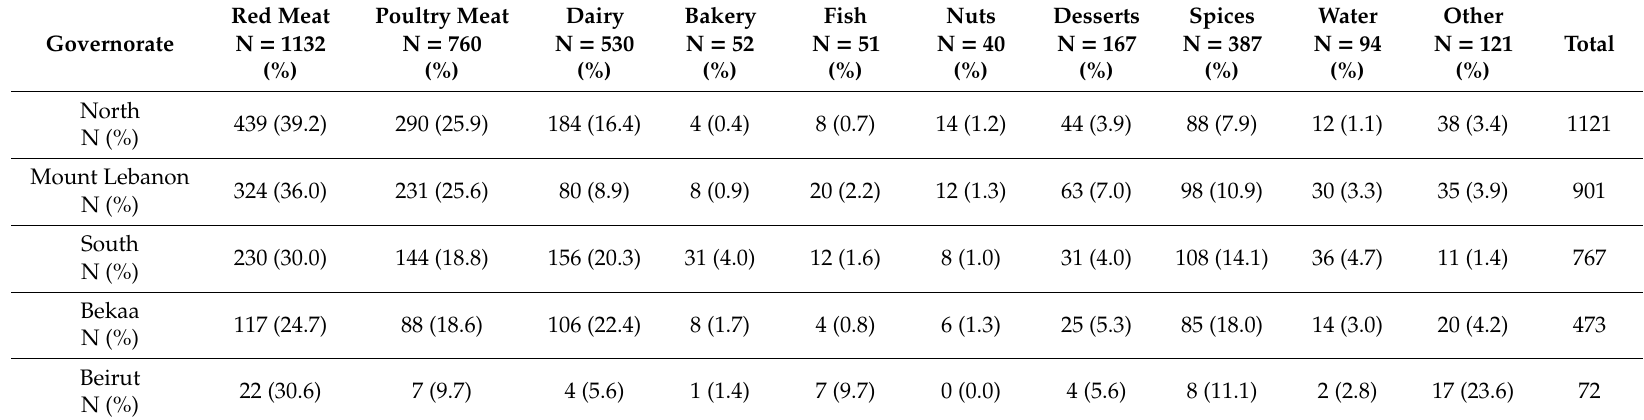
Table 3. Comparison of the number of microbially unacceptable samples in each food category across Lebanese governorates (administrative divisions of Lebanon). Red Meat Governorate N = 1132